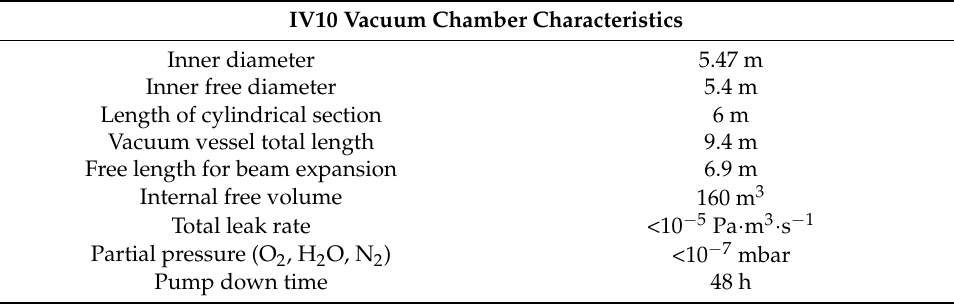
Figure 2. Schematic of the IV10 vacuum facility and its main dimensions ( a ). Opening cap and the bi-conical beam target ( b ). Table 1. Main Characteristics of the IV10 vacuum